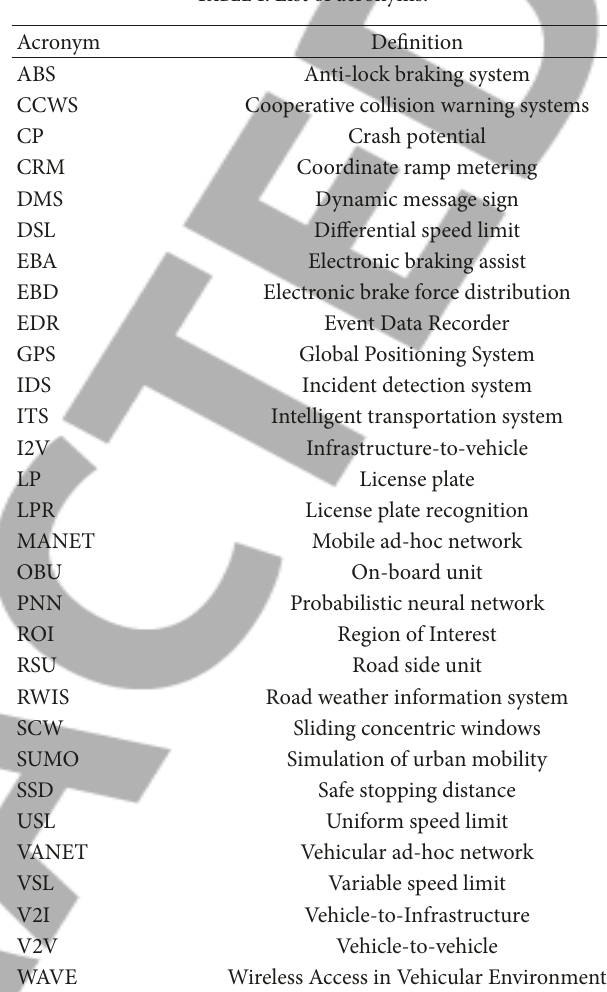
Table 1: List of